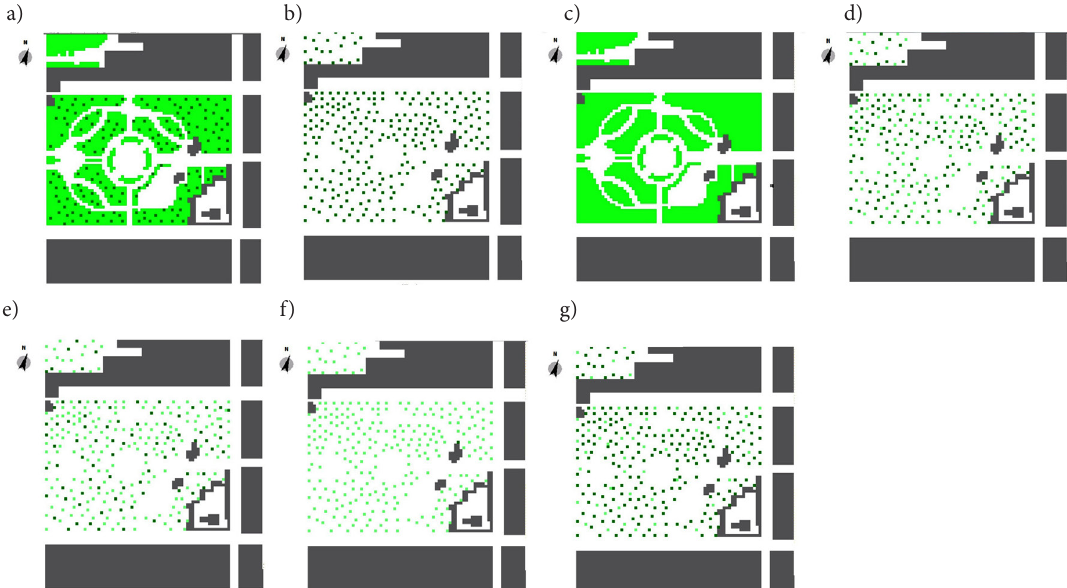
Figure 2. Simulated scenarios in the park with different planting design, a): the current park, b): 100% evergreen trees, c): 100% grass, d): 50:50% deciduous and evergreen trees, e): 70:30% deciduous and evergreen trees, f): 100% deciduous trees and g): 30:70% deciduous and evergreen trees. EVI-Met software 3.0., Leonardo